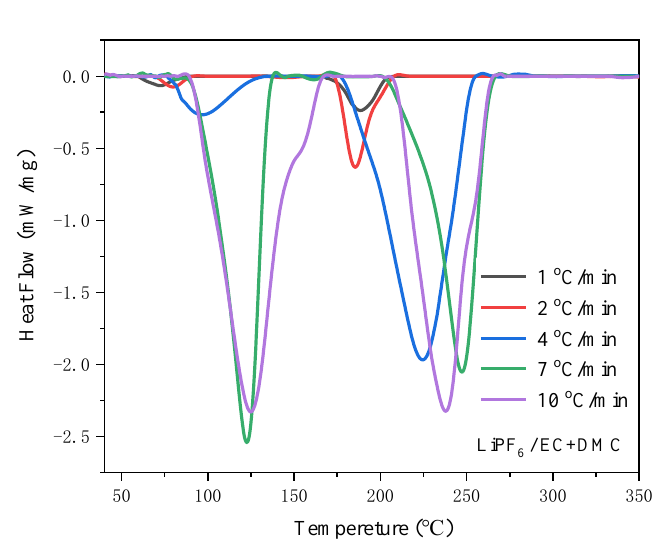
Figure 1. DSC curves of 1 M LiPF 6 /EC + DMC (2:3, v/v ) at five different β .